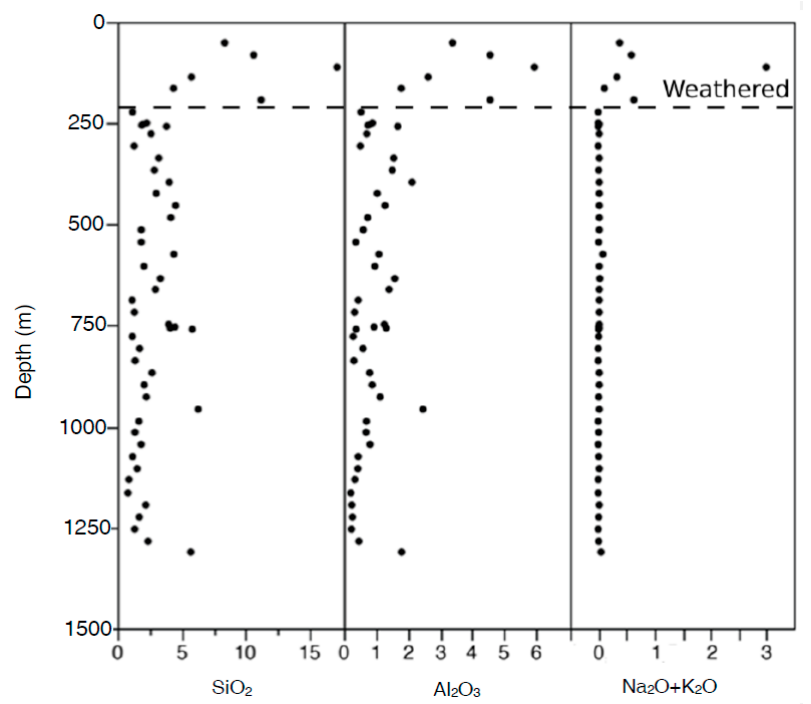
Figure 7. Abundance of silica, aluminium and potassium (wt %) as a function of depth within the Saint-Honoré Fe-carbonatite. Note that the uppermost 250 m are strongly weathered.